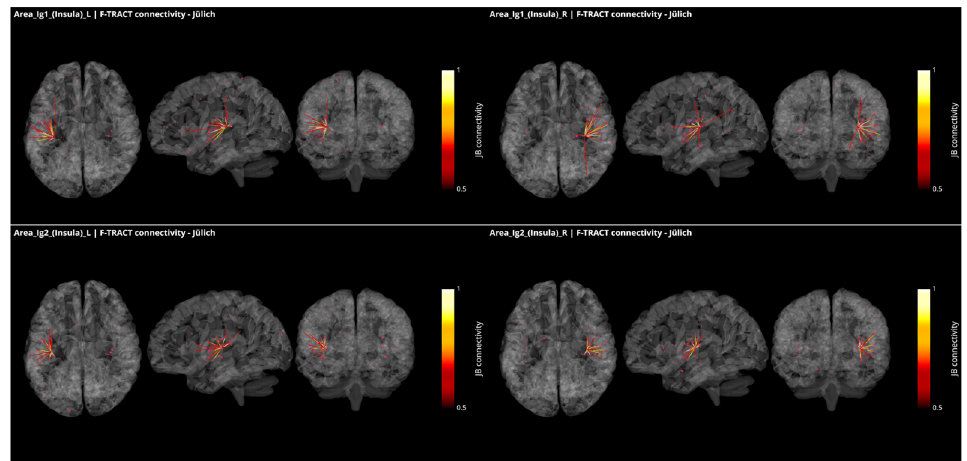
Figure 4. Intracortical connectivity of the two granular subregions of the insula. From top to bottom: area Ig1 and area Ig2. Left column for the subregions of the left hemisphere and right column for the subregions of the right hemisphere. Image derived from the data of the F-TRACT project (https://f-tract.eu), version of 1 December 2021.